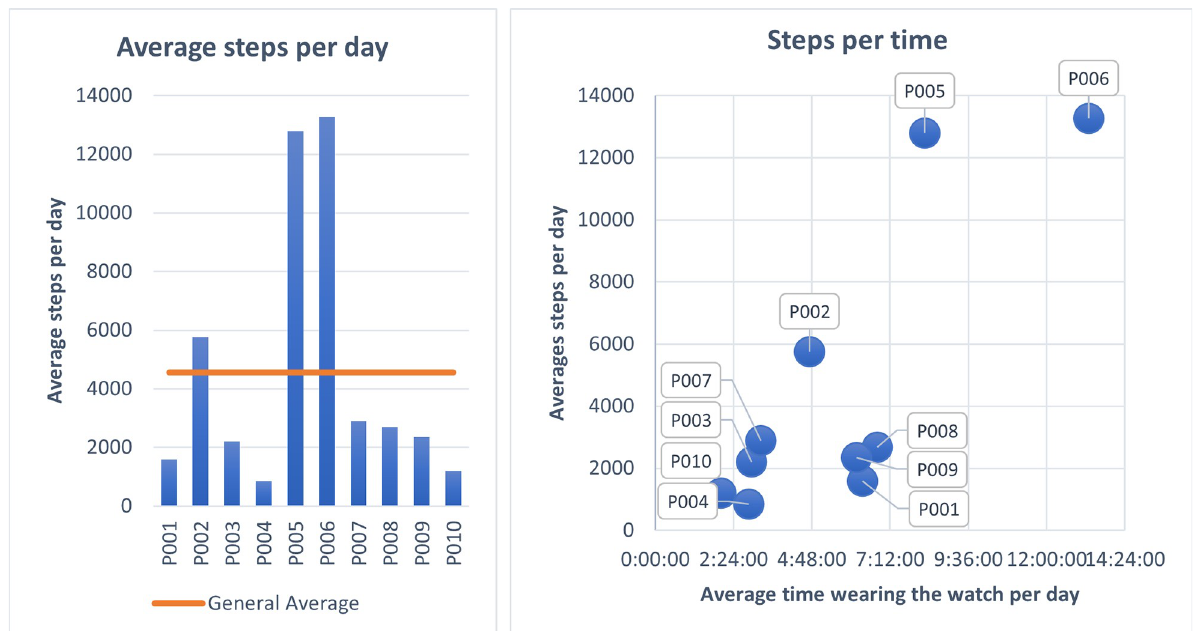
Fig 3. Steps. Average steps participants completed per day (left), and the comparison of steps per day and time each child wore the smartwatch (right).